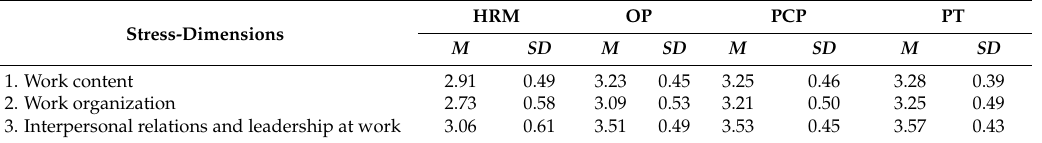
Table 4. Perceived relevance of work-related